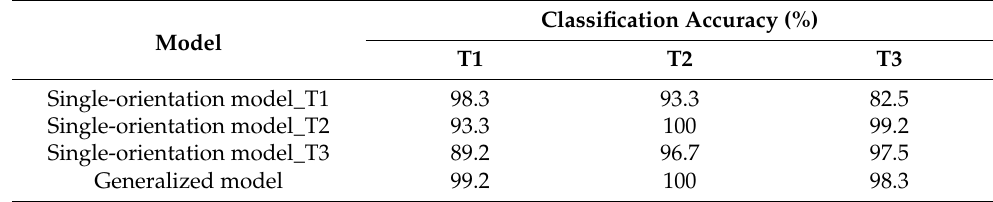
Table 3. Prediction results of single-orientation model and generalized model (S–G + Normalization).